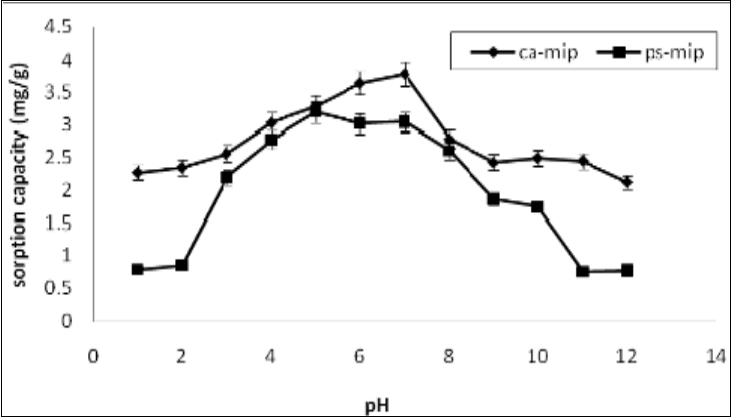
Figure 5. Effect of pH on the removal of 2,4-DNP by CA-MIP and